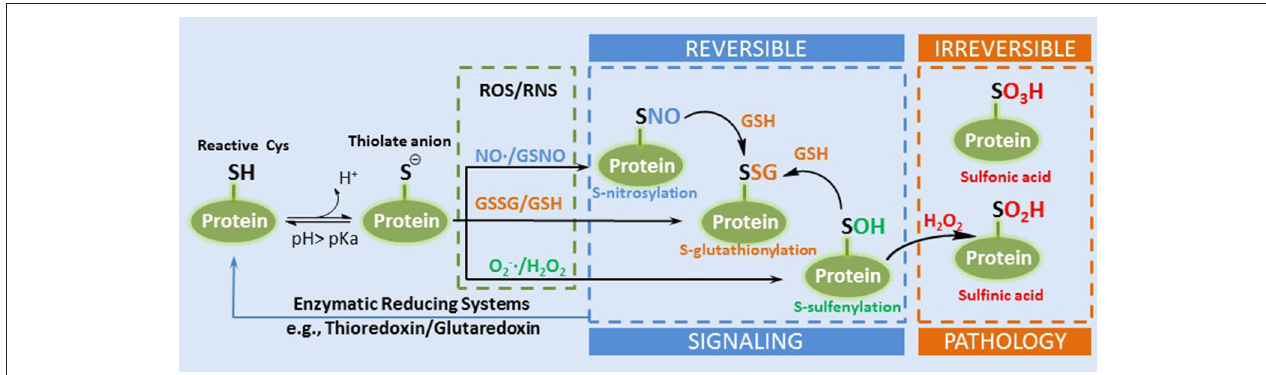
FIGURE 2 | A simplified diagram of the formation of thiol redox PTMs. A reactive Cys can exist as thiolate anion under physiological pH. The thioate anion is reactive with different ROS or RNS to form several types of reversible redox PTMs such as SNO, SSG, and SOH. SOH can be further oxidized into irreversible sulfinic and sulfonic acid (Adapted from Filomeni et al. Cell Death and Differentiation 2005, Filomeni et al., 2005).